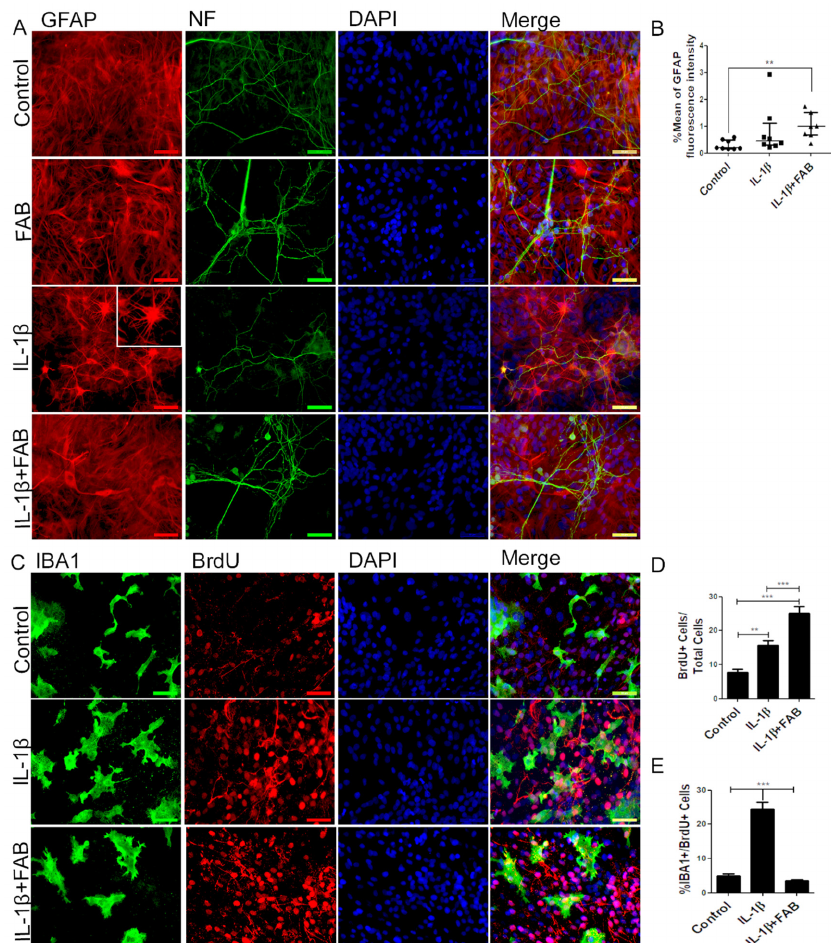
Figure 5. Agathisflavone preserves neuronal and astrocyte morphology, as well as decreases microglia proliferation. ( A ) Representative photomicrographs of immunocytochemistry for the astrocyte marker GFAP (red) and the axonal marker neurofilament (green), counterstained with the nuclear dye DAPI (blue); scale bar: 50 µm. ( B ) Boxplot graph showing GFAP fluorescent intensity; values are expressed as the median and were tested for significance using the Kruskal–Wallis test followed by Dunn’s test. ( C ) Analysis of cell proliferation by BrdU (red) incorporation into the DNA of microglia cells (Iba-1, green) exposed to 1 µM of agathisflavone or in control conditions (0.1% DMSO) 24 h after treatment, counterstained with the nuclear dye (blue); scale bar: 50 µ m. ( D , E ) Bar graphs show the quantification of total BrdU + / DAPI cells (D) and Iba-1 / BrdU + microglia; values are expressed as the mean ± SEM ( n = 3) and were tested for significance by one-way ANOVA. ** p < 0.01 and *** p <